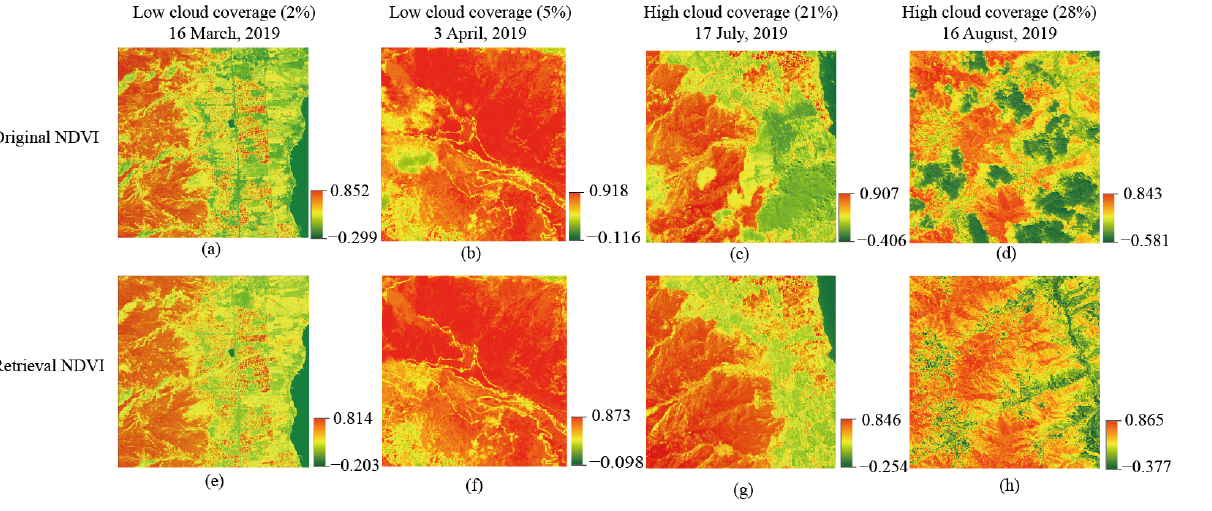
Figure 7. NDVI retrieval results of the double-attention RNN under various cloud coverage condi- tions; ( a – d ) are original NDVI images with low and high cloud coverage conditions, respectively. ( e – h ) show the retrieval results under two cloud coverage conditions of the double-attention RNN. The figures are colorized with diverging colormaps; the intermediate value is depicted in yellow, and the high value and low value are shown in red and green. As shown in the above figure, the first row exhibits the original NDVI images, and the NDVI retrieval results of the double-attention RNN are shown in the images of the